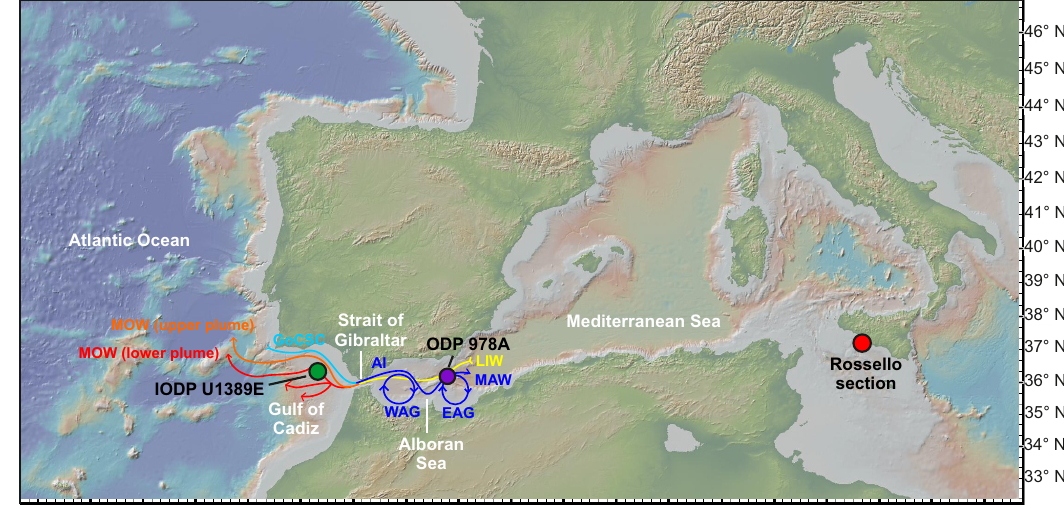
Figure 1. Location of IODP Site U1389, ODP Site 978, and the Rossello section. AI: Atlantic Inflow; EAG: Eastern Atlantic Gyre; GoCSC: Gulf of Cádiz Slope Current; MAW: Modified Atlantic Water; MOW: Mediterranean Outflow Water; WAG: Western Atlantic Gyre. The map was generated with GeoMapApp (http://www.geomapapp.org), using the default basemap, Global Multi-Resolution Topography (GMRT) Synthesis (Ryan et al.,